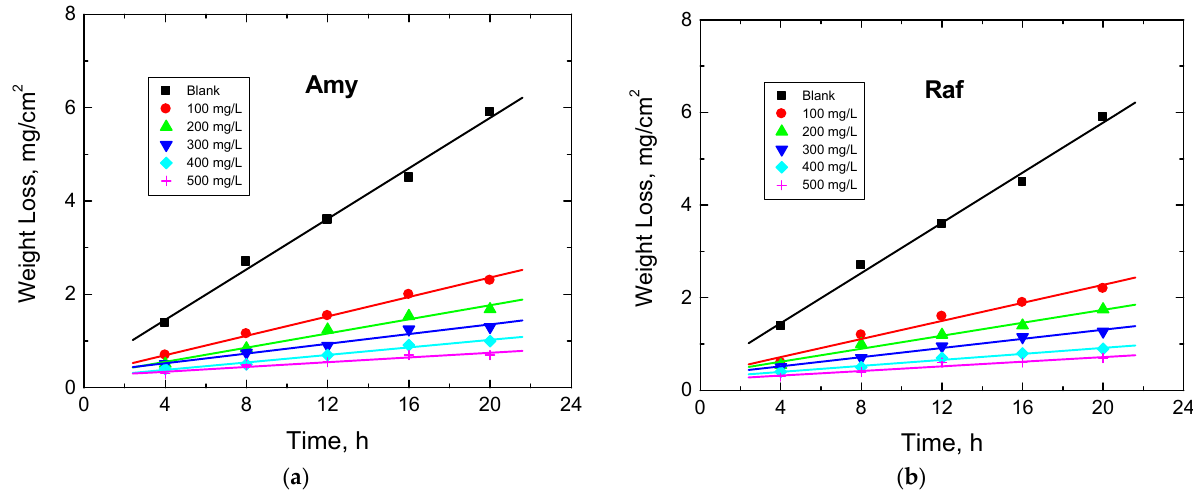
Figure 7. Plots of WL vs. dipping time for Al corrosion in 0.1 M NaOH medium and with, ( a ) Amyg- dalin (Amy), and ( b ) Raffinose (Raf) at 298 K. Table 4. The mean values of corrosion rates ( CR s) of Al in 0.1 M NaOH medium and with Amy and Raf at various temperatures.